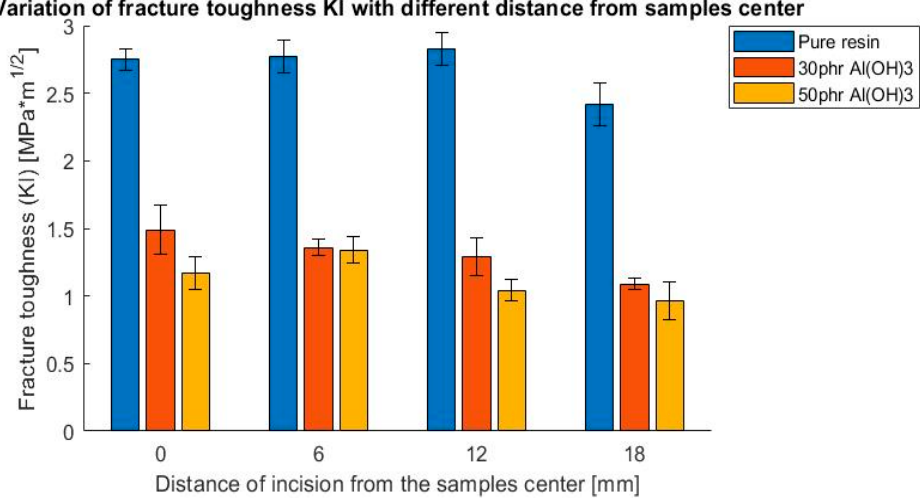
Figure 9. Variation of fracture toughness K I with different distances from sample center, 3-point bending test.